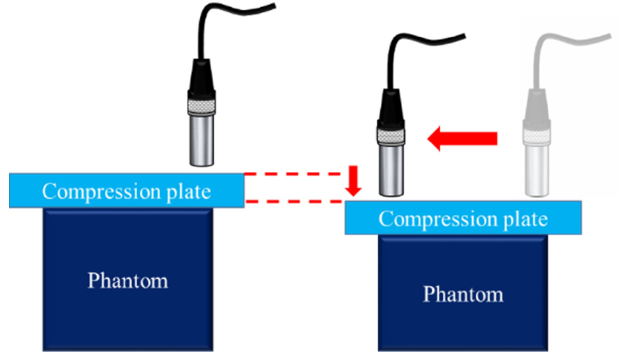
Figure 3. Measurement method.